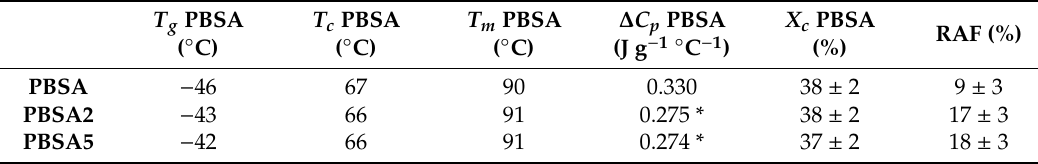
Table 1. Thermal properties of the neat filled PBSA films.